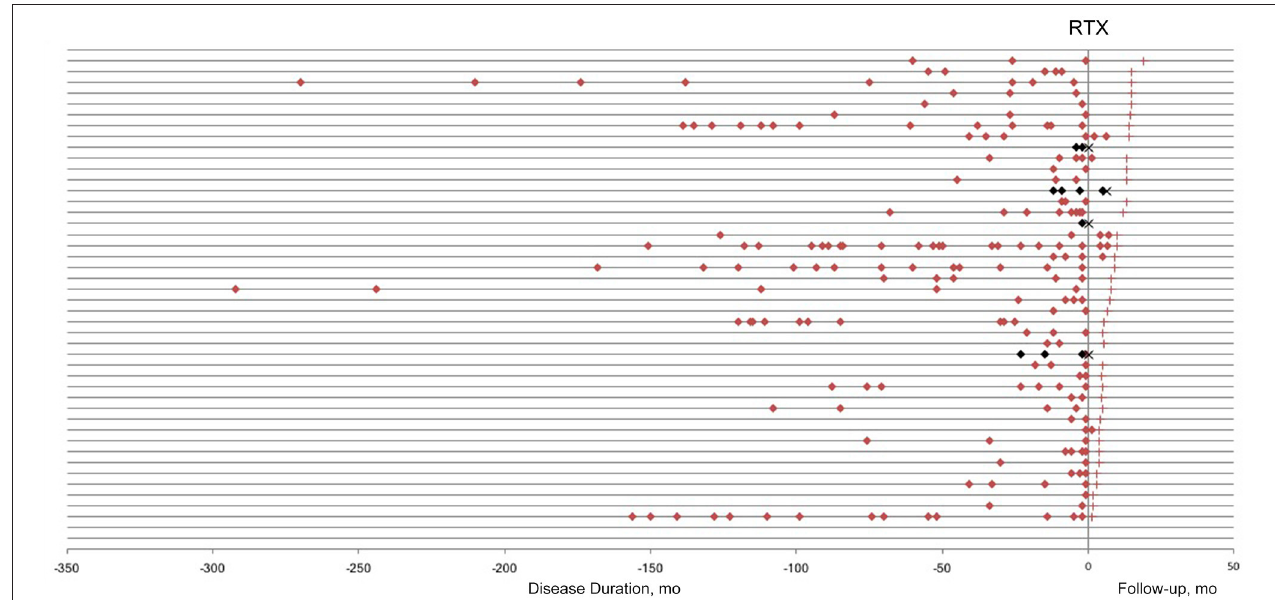
FIGURE 1 | Relapses in neuromyelitis optica-associated optic neuritis patients before and after low-dose rituximab (RTX) treatment. Each horizontal line represents a patient. Red/Black square, relapse; red cross, last follow-up; black cross, lost to follow-up.